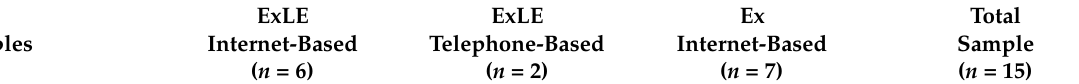
Table 2. Sociodemographic and clinical characteristics of the